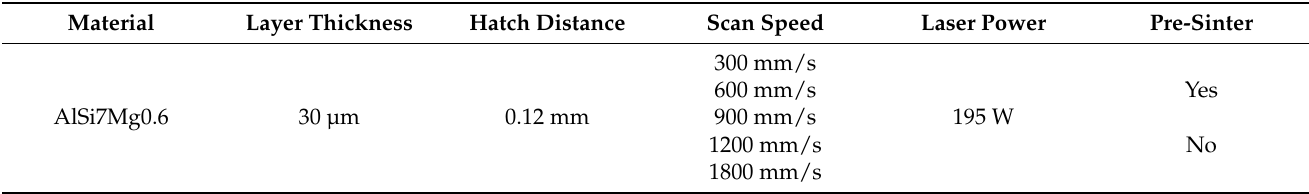
Table 3. Variation of contour scan parameters.